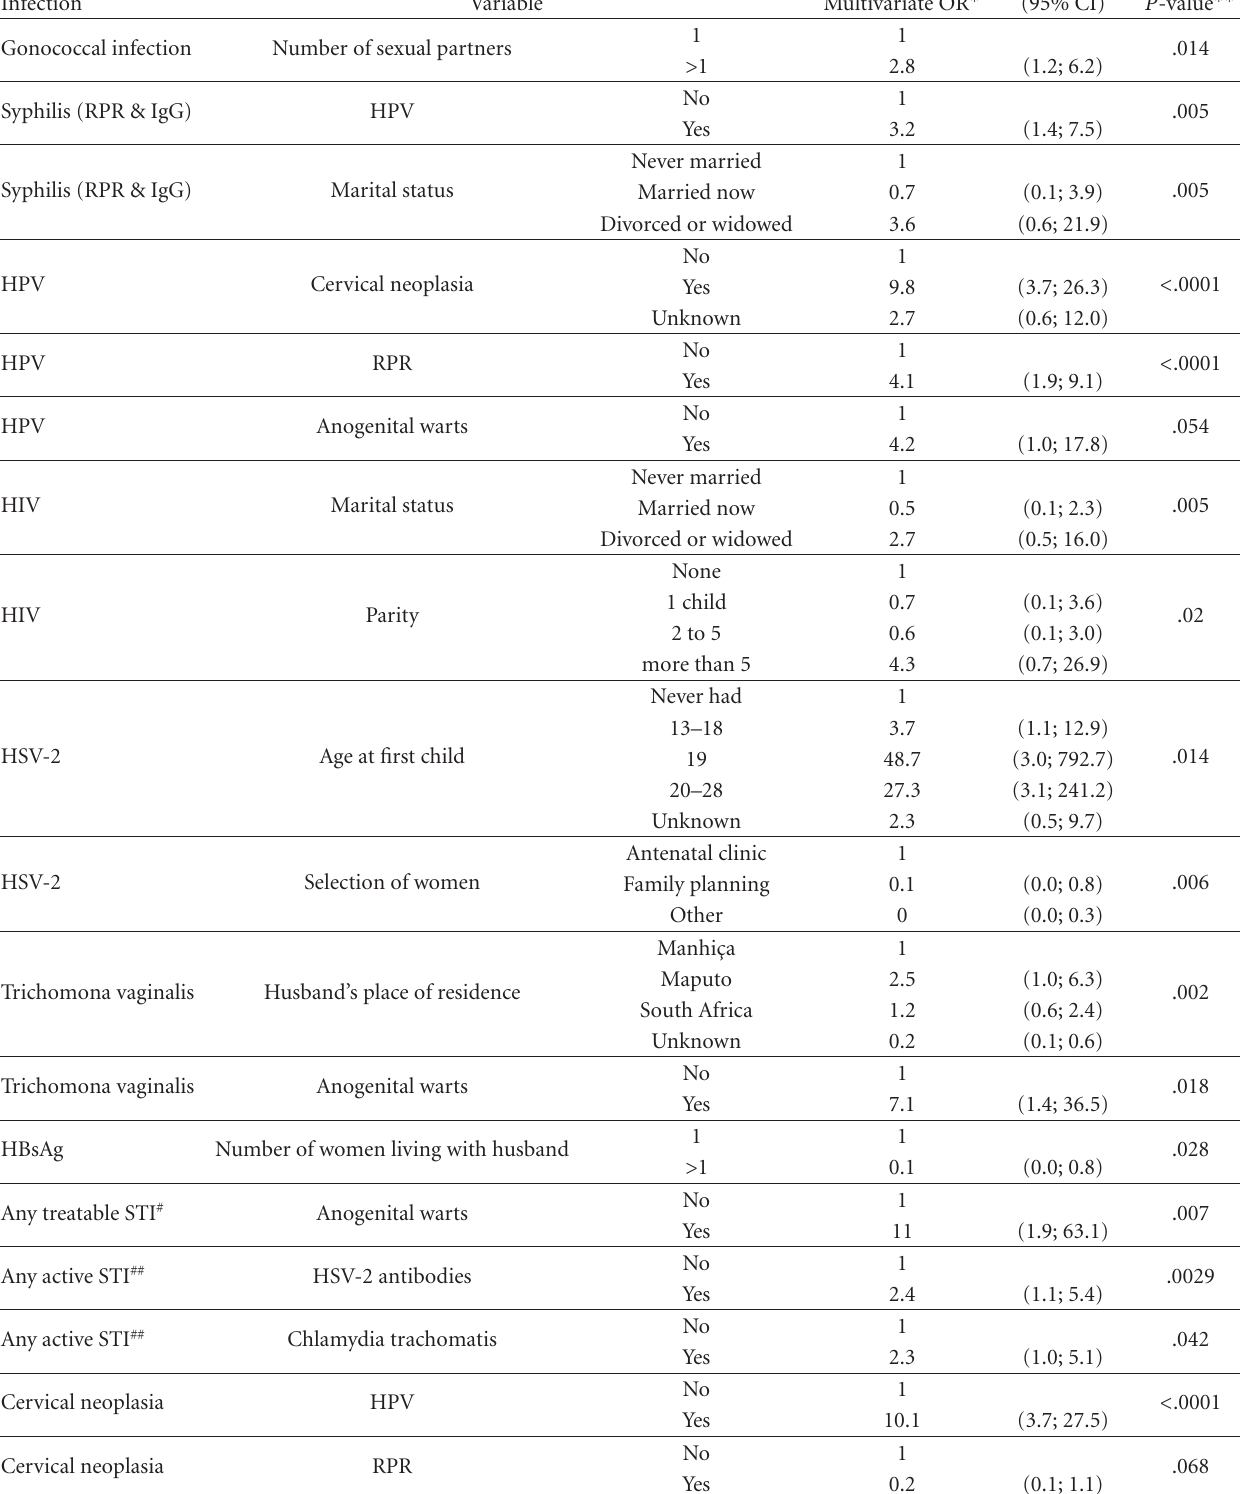
Table 3: Significant variables according to the multivariate analysis of risk factors for STIs and cervical